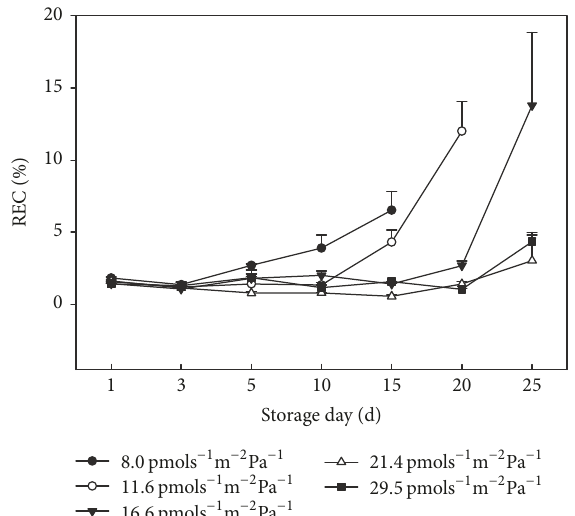
Figure 3: Effects of packaging with different OTR on tissue electrolyte leakage, expressed as relative electrical conductivity (REC), of Chinese toon tender shoots during storage at 4 ∘ C. Data points represent the mean ± SE ( 𝑛 = 4